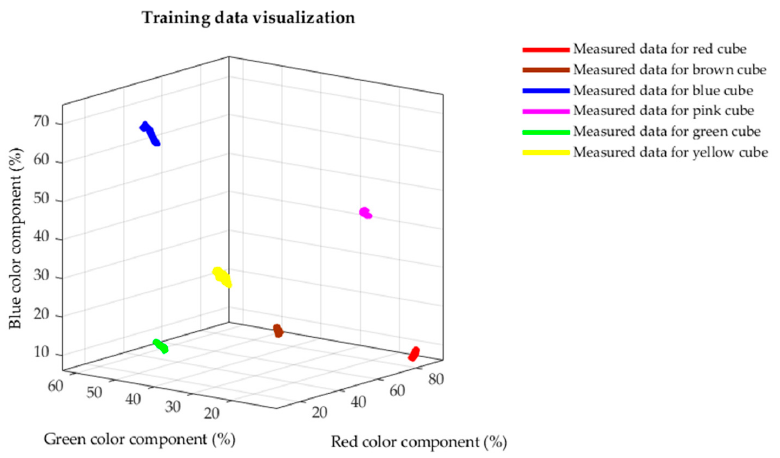
Figure 8. Visualized training data.